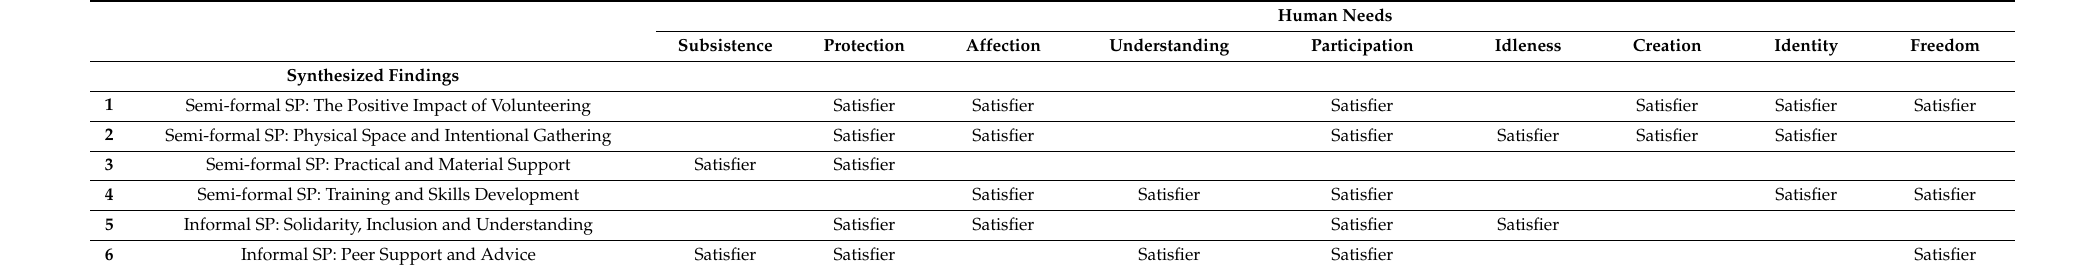
Table 3. Semi-Formal and Informal Social Protection (SP)—Human Need Satisfiers.